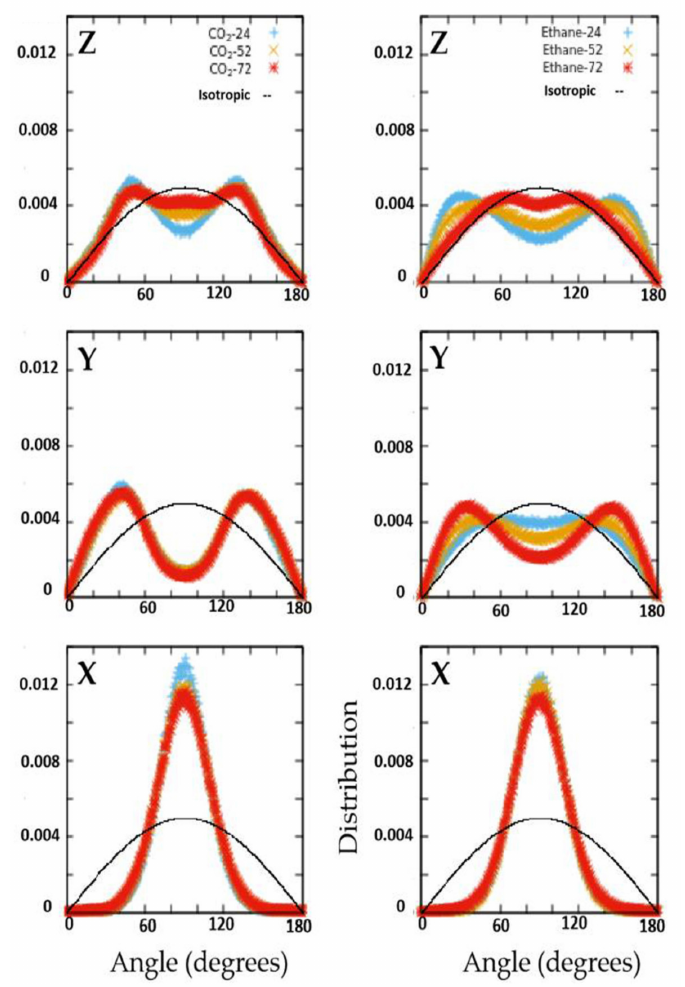
Figure 3. Distribution of angles made by the molecular axis of the guest molecules with respect to Cartesian directions for all loadings investigated in the case of ethane and CO 2 . The distribution for an isotropic case with no preferred orientation is shown as a black curve for